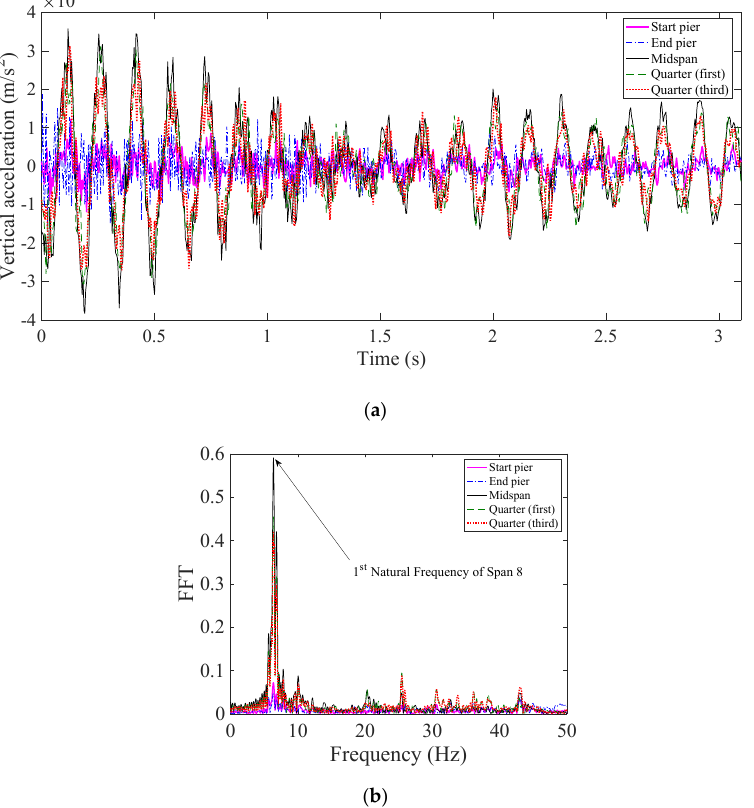
Figure 4. Free − vibration response of Span 8: ( a ) in time domain, and ( b ) in frequency domain.